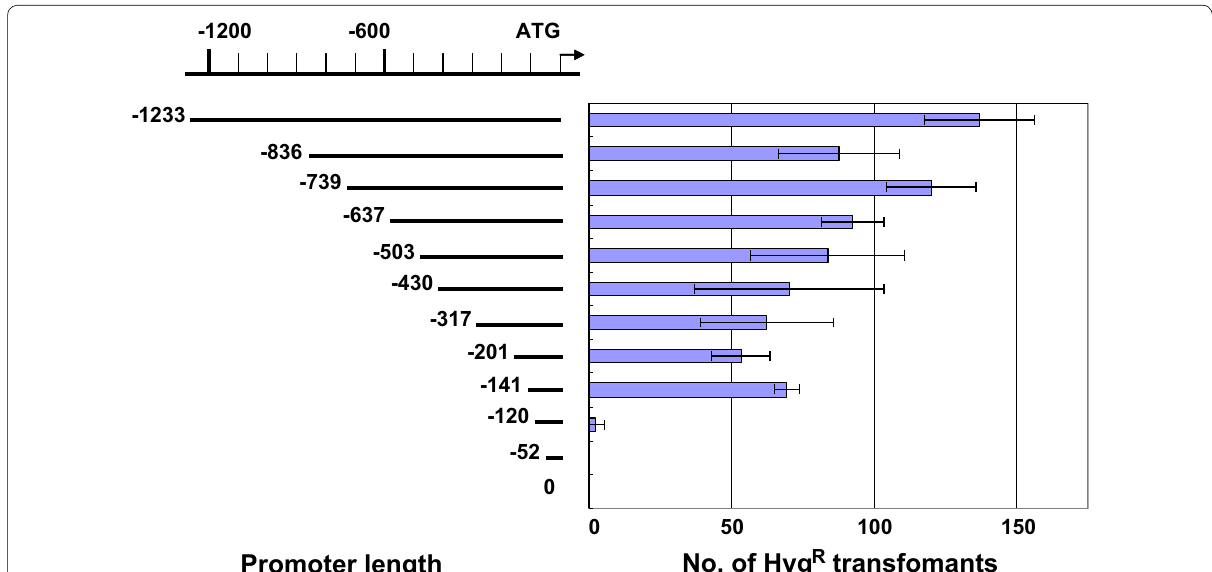
Fig. 4 Promoter analysis of C. subvermispora gpd using transformants. Promoter constructs used in deletion analysis of the Csgpd promoter, and number of drug-resistant transformants (n 3, SD) grown on the first screening plate containing 200 µg/ml hygromycin B. The A nucleotide in = ± the first ATG was counted as +